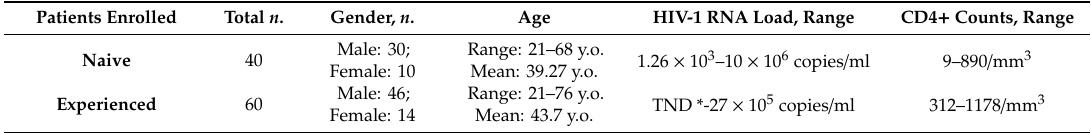
Table 3. Demographics and clinical features of HIV-1 positive individuals at